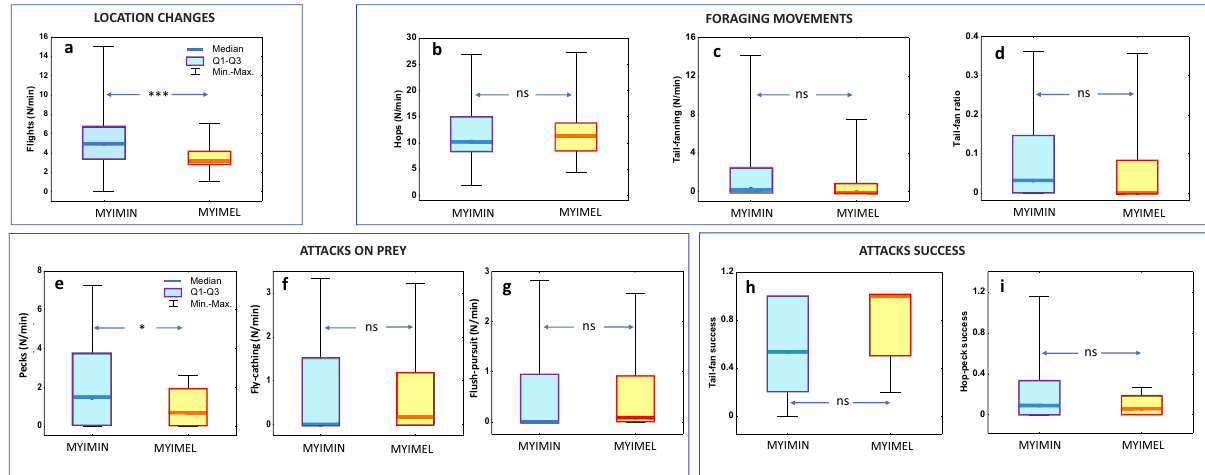
Figure 5. Comparison between M. miniatus (MYIMIN) and M. melanocephalus (MYIMEL) in their foraging behaviour. ( a ) Foraging location changes described by flights (nr flights/min); ( b ) Foraging movement rate described by hops (nr hops/min); ( c ) flush-pursue foraging movement rate described by tail-fanning (nr of hops with tail fanned/min); ( d ) relative used of the flush-pursue foraging movements as measured by tail-fan ratio ( tail-fanning /( hops + tail-fanning ); ( e ) attacks on prey by pecking, pecks (nr/min); ( f ) attacks on prey by fly-catching (nr/min); ( g ) attacks on prey by flush-pursuing, flush-pursuit (nr/min); ( h ) flushing success of the fanned tail and wings as measured by tail-fan success (proportion of tail-fan-hops that resulted in pursuit); ( i ) success in detecting and attacking stationary prey as measured by hop-peck success (proportion of hops that resulted in pecking). In ( h ), n = 20 and n = 12 for M. miniatus and M. melanocephalus , respectively. In all other panels, n = 39 and n = 26 for M. miniatus and M. melanocephalus , respectively. ***Differences statistically significant at P < 0.001; *Differences statistically significant at P < 0.05; ns differences not statistically significant; box charts: line—mean; box—SE; whiskers—95% confidence limits. Full set of statistical analyses is reported in Supplementary Table S4 in Supplementary Materials Part 3.